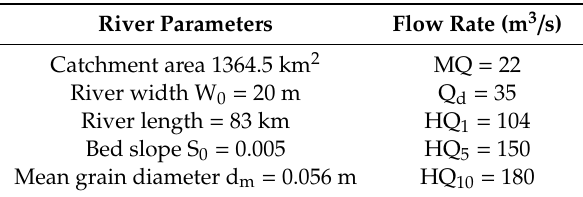
Table 1. River parameters and hydrological characteristics at the gauging station